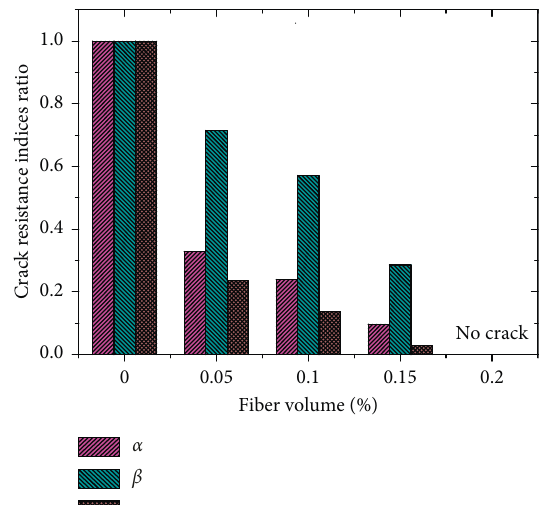
Figure 14: Ratio of crack resistance index for BFRC for specimens with different fiber volume fractions (BF 30-18-0.05 ∼ 0.20) as compared to plain concrete (PC)